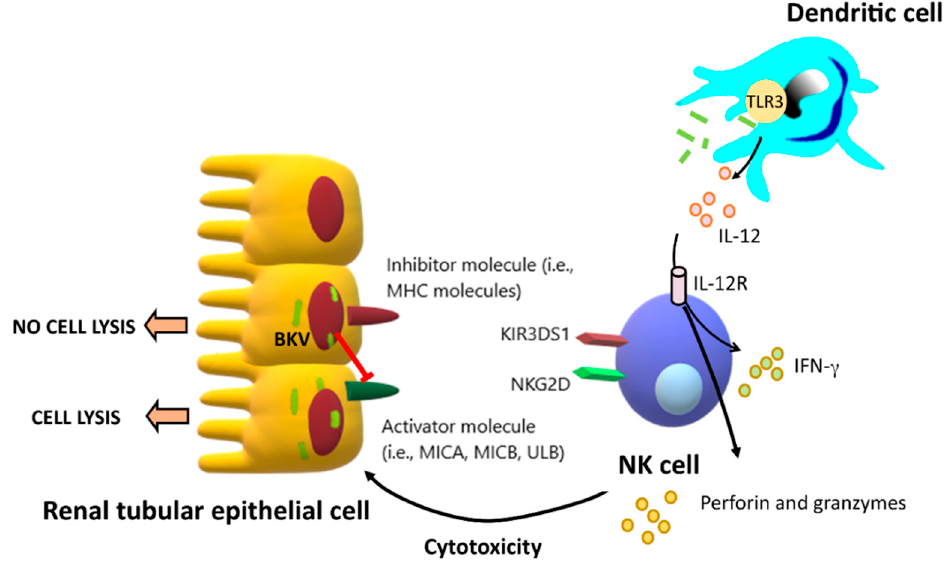
Figure 2. The interaction between dendritic cell and NK cell during BK virus infection. BK virus (BKV) escapes the innate immunity through the inhibition of several activator molecules and the induction of transforming growth factor (TGF)- β in the infected renal tubular epithelial cells to suppress NK cell functions. Meanwhile, NK cell eradicates BKV through antibody-dependent cellular cytotoxicity (ADCC) mechanism. NK, natural killer cell; IFN, interferon; IL, interleukin; TLR, toll-like receptor.